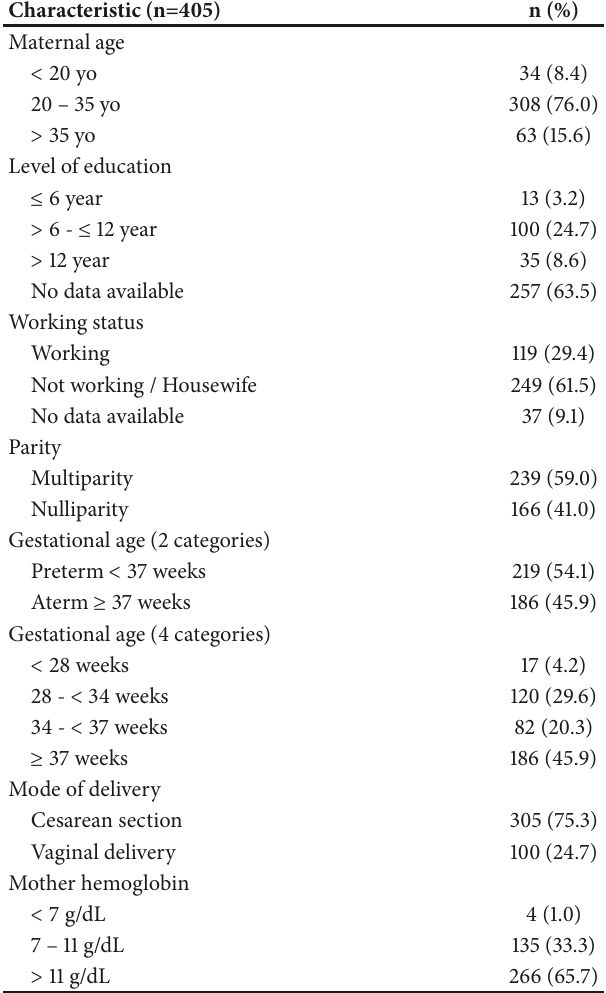
Table 1: Subjects characteristics of patient with